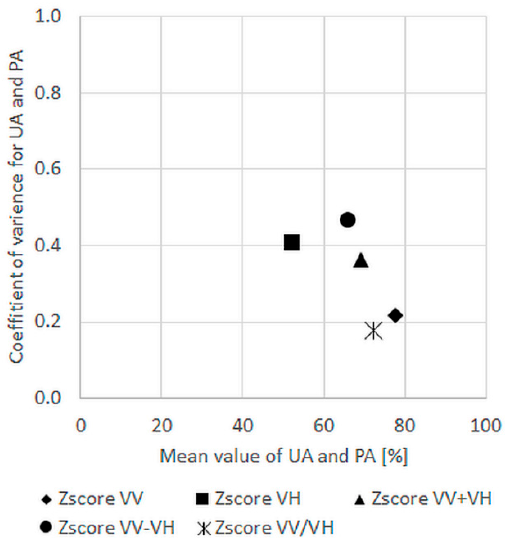
Figure 13. Comparison of pixel-based time series features as a function of mean value and coefficient of variation. The statistical values (mean value and coefficient of variance) were calculated on the basis of the PA and UA accuracy values.